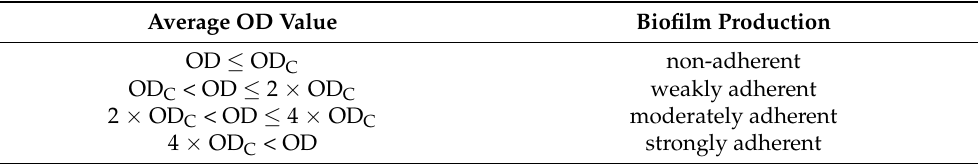
Table 2. Interpretation of biofilm